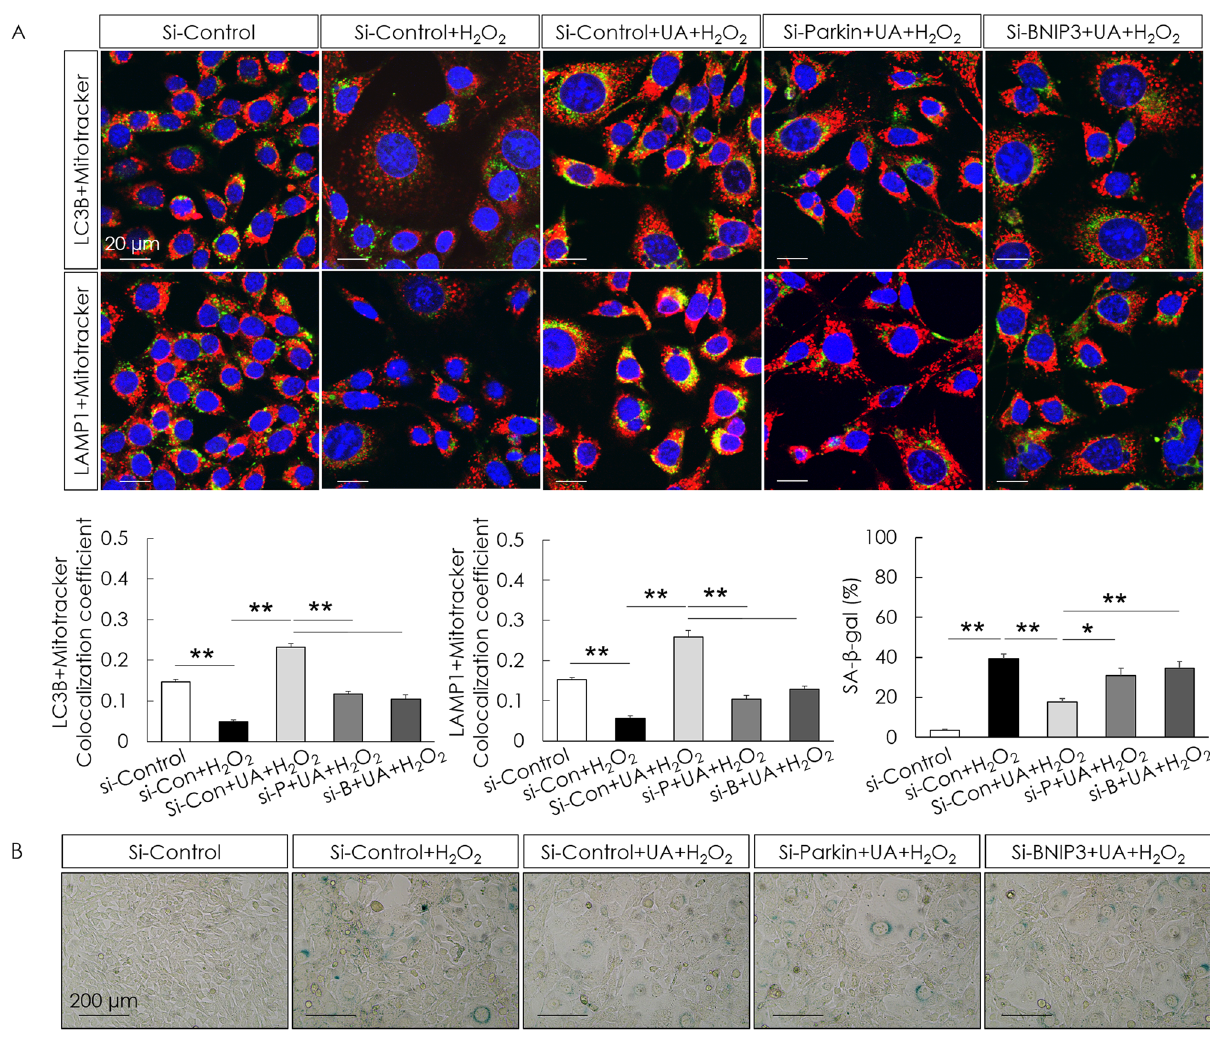
Figure 5. Effect of knockdown of Parkin and Bnip3 on UA-induced anti-senescent activity in HEI-OC1 cells. The co-localization areas (yellow puncta) of LC3B and MitoTracker, and LAMP1 and MitoTracker were significantly increased in si-Control H 2 O 2 -treated cells upon UA pre-treatment, whereas they were significantly decreased post siRNA-mediated knockdown of Parkin and Bnip3 ( A ). UA pre-treatment significantly decreased the percentage of β-gal-stained cells following H 2 O 2 treatment of si-Control HEI-OC1 cells, whereas the percentage of β-gal-stained cells was not reduced in cells transfected with Parkin and Bnip3 siRNAs ( B ). Data are presented as means ± standard errors of the mean of five independent experimental results (UA, Urolithin A; SA-β-gal, senescence associated-beta galactosidase). * p < 0.05, ** p <